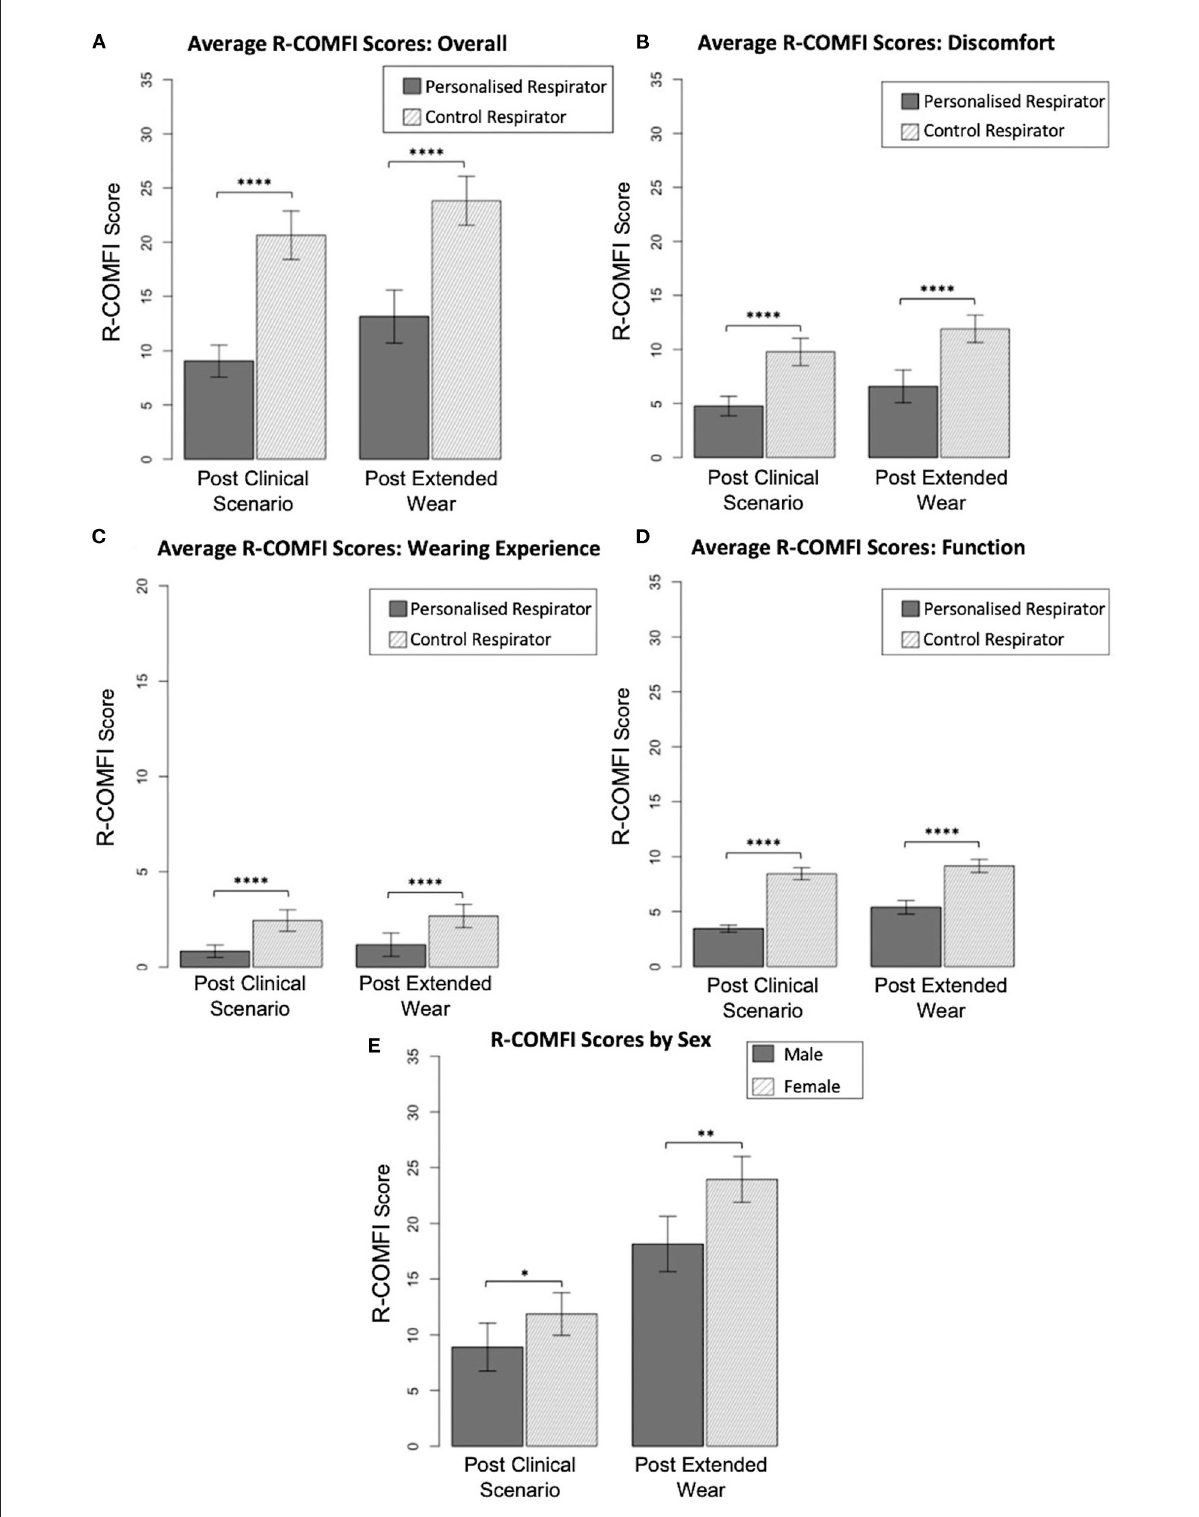
FIGURE4 Comparison of R-COMFI scores. (A) Overall R-COMFI scores for personalized vs. control respirators following simulated clinical scenario and extended at home wear. (B) Comparison of discomfort subsection scores. (C) Comparison of wearing experience subs subsection scores. (D) Comparison of function subsection scores. (E) Sex differences in R-COMFI score for personalized vs. control respirators. Error bars represent 95% confidence interval. P < 0.05 are denoted by “ * ,” < 0.01 by “ ** ,” and < 0.0001 by “ ****